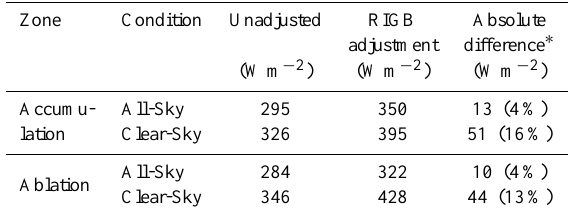
Table 3. Daily average improvements in